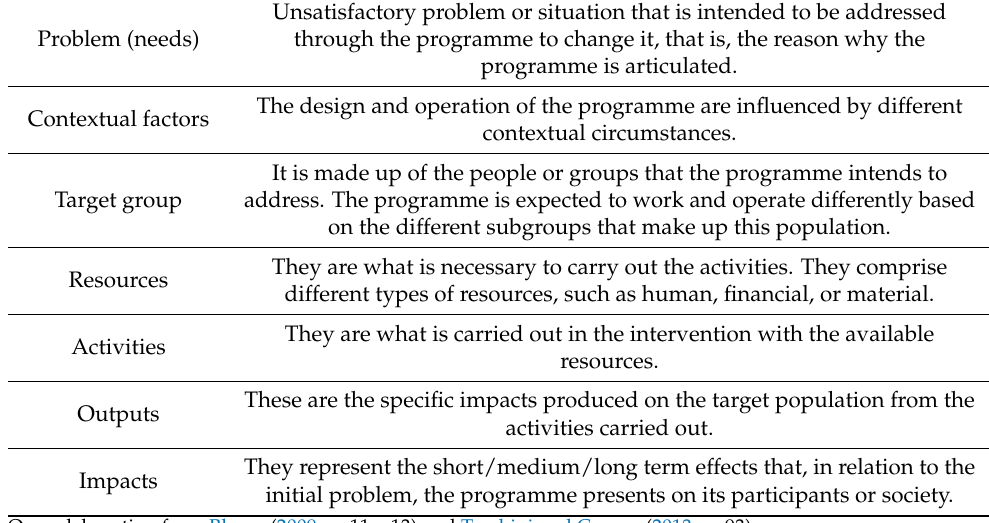
Table 2. Components of the logical